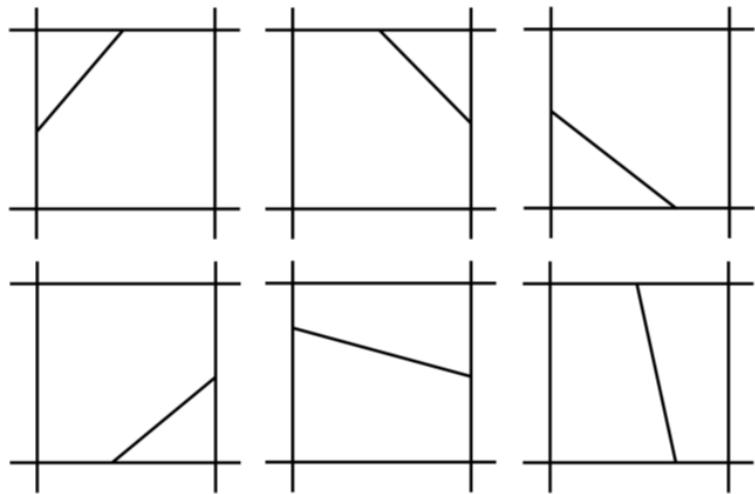
Figure 6. Two equivalent points.